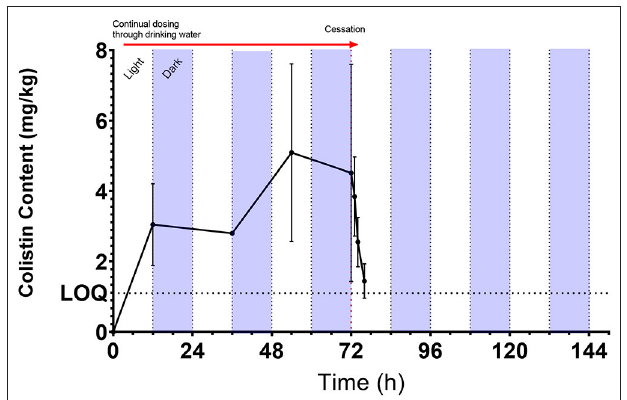
FIGURE 1 | Mean [ ± SD; n = 6 (0, 12, 36, and 54h) or 8 (72h onward)] colistin content (mg/kg) as measured by UHPLC-MS/MS in chicken luminal intestinal content during and following administration of 75,000 IU/kg colistin sulfate via drinking water. Red arrow denotes period of dosing via drinking water from administration of dosing at 7a.m. Light/dark cycle represents photo- and scotoperiods.